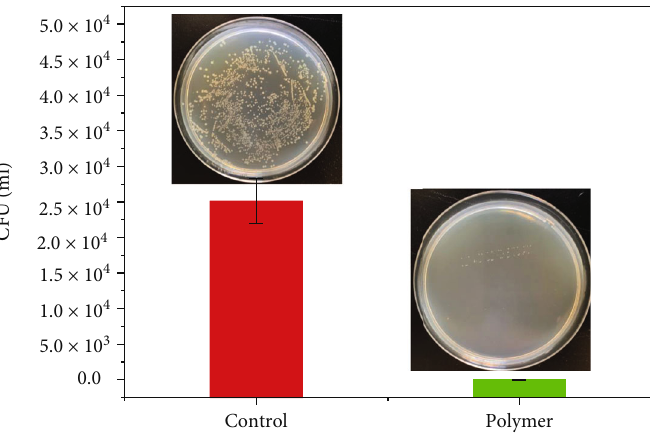
Figure 9: S . aureus adhered to the control and polymer